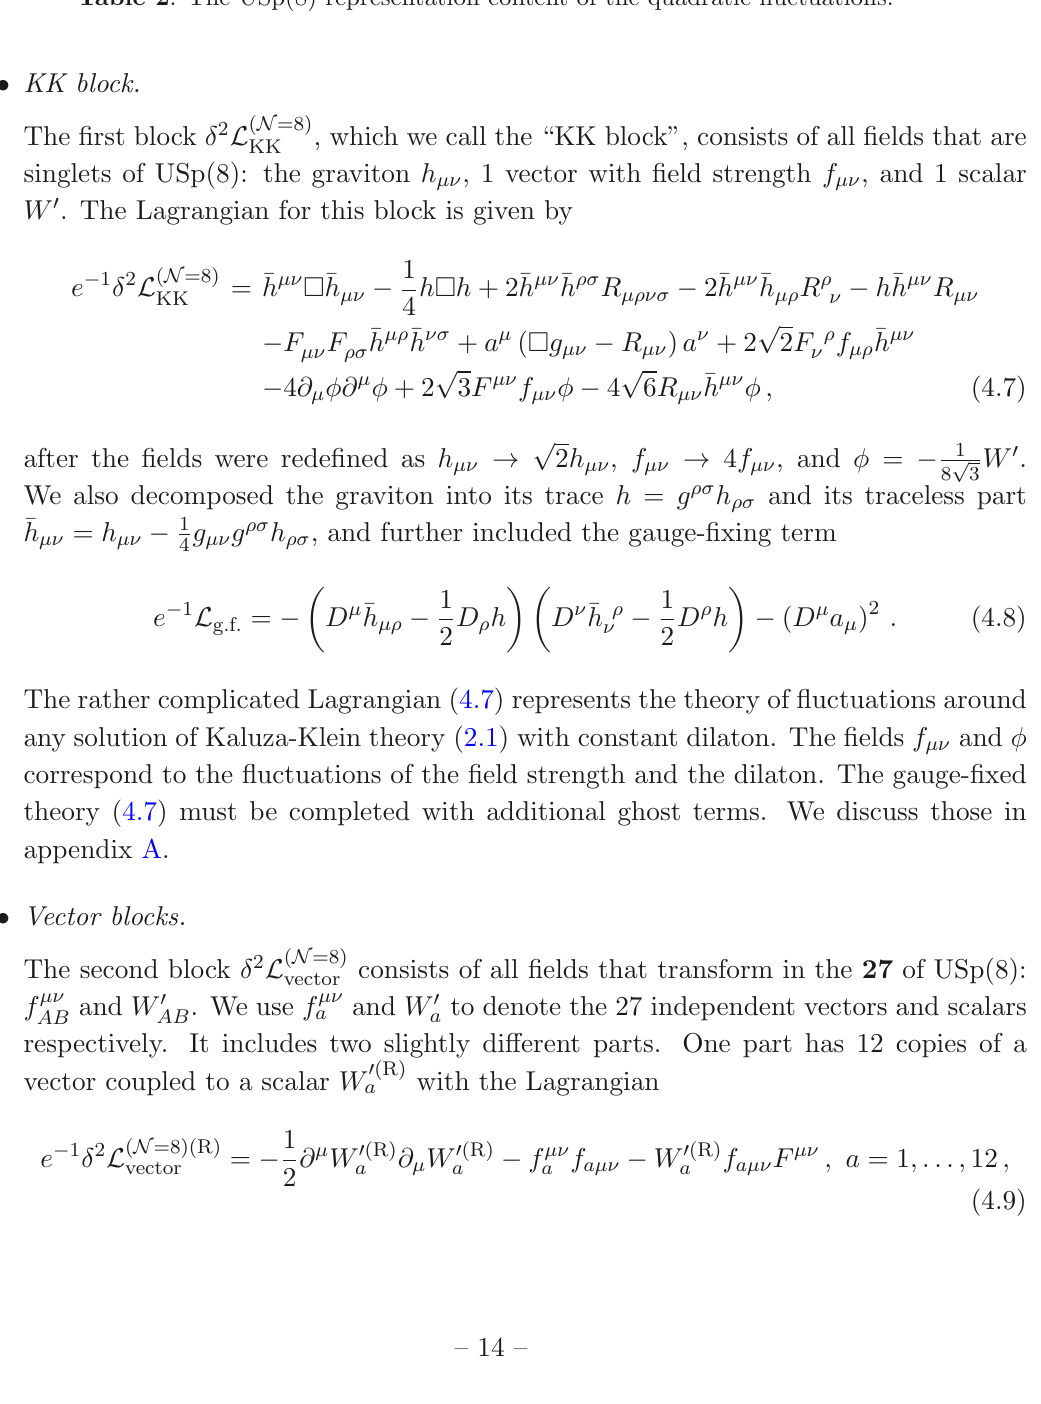
Table 2 . The USp(8) representation content of the quadratic